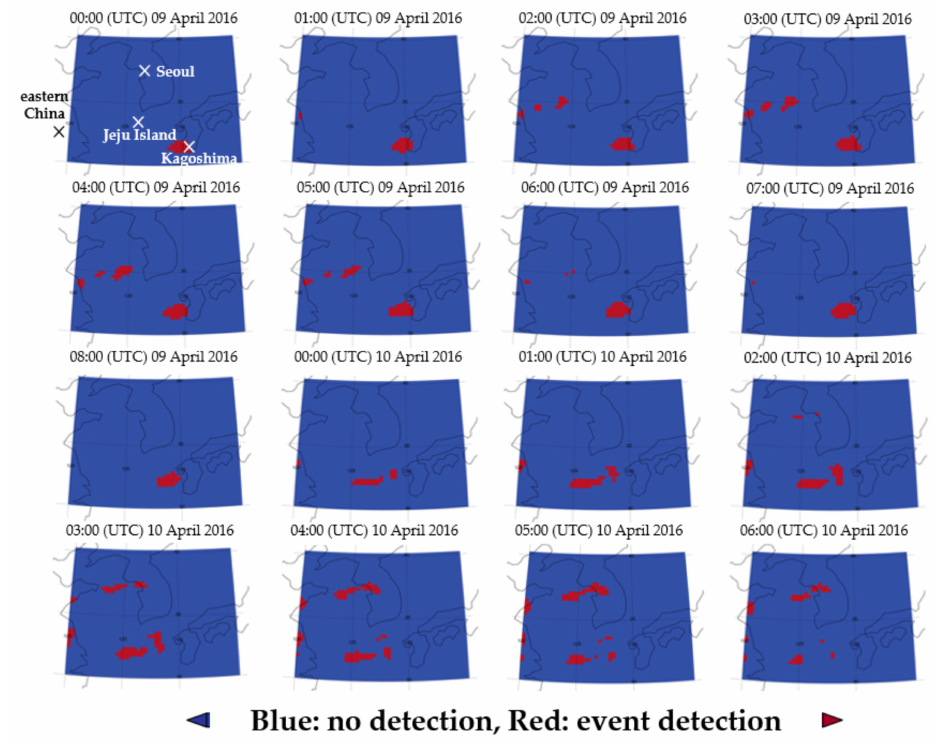
Figure 12. Spatial distribution of pixels affected by anthropogenic and volcanic LRT-SO 2 for event 1 over the period 9–10 April 2016. Red indicates the pixels affected by LRT-SO 2